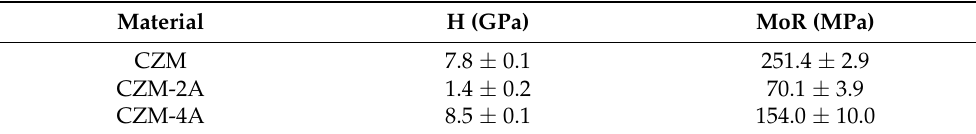
Table 5. Hardness (H) and modulus of rupture (MoR) of the